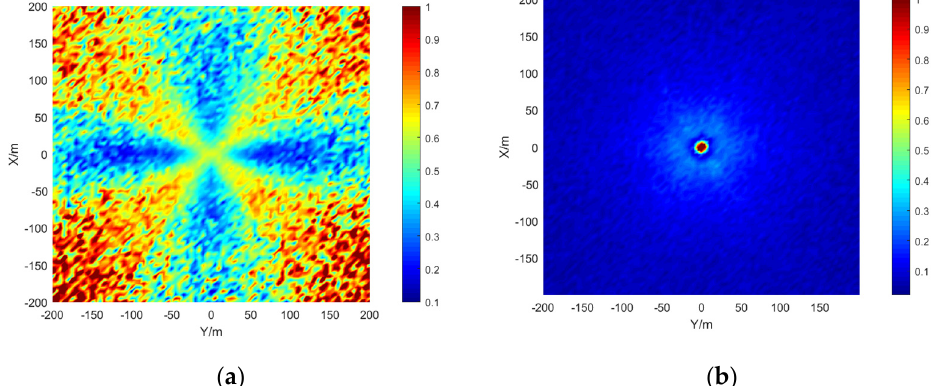
Figure 10 Positioning accuracy of stereo array 2. ( a )parallel wave algorithm ( b ) vector projection algorithm.